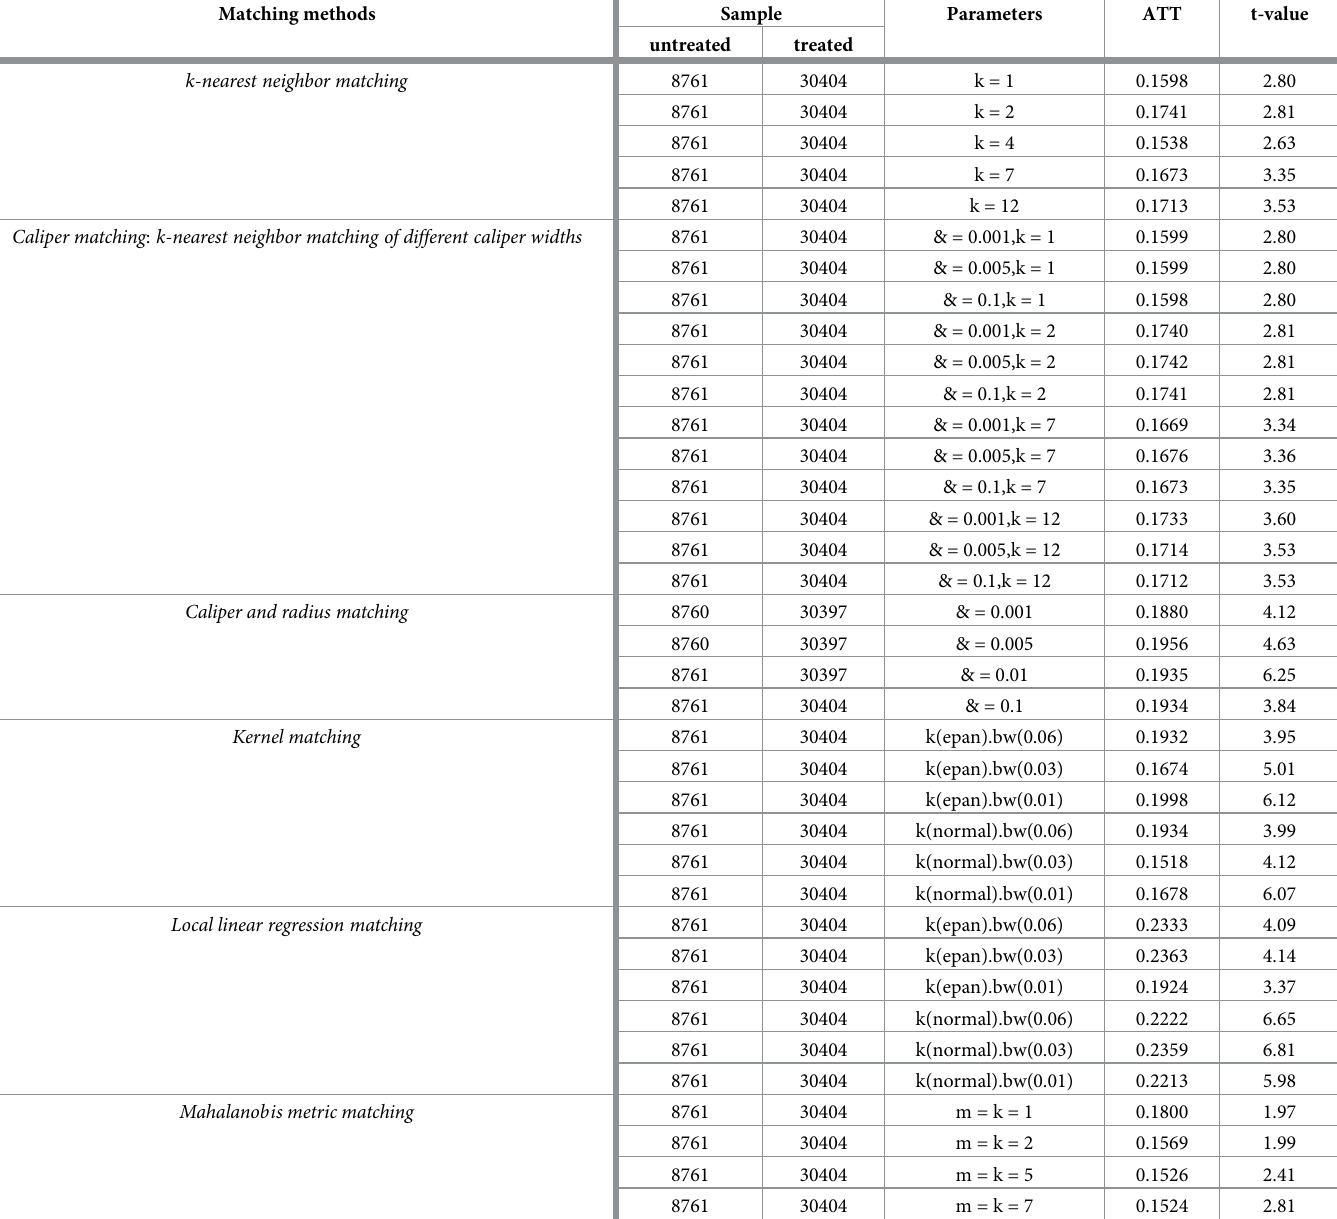
Table 7. The migration effect on the average monthly wage for the different matching methods and parameter values. Matching methods Sample Parameters ATT t-value untreated